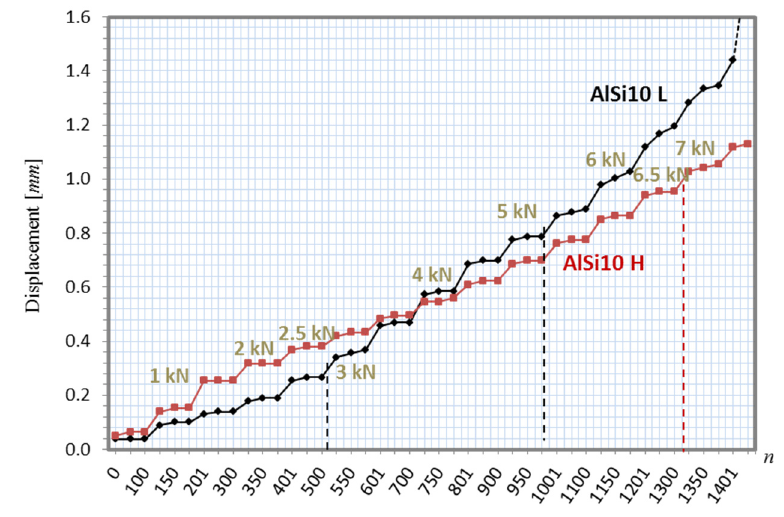
Figure 12. Displacement vs. cycle number with staircase loading of foam-filled tubes.